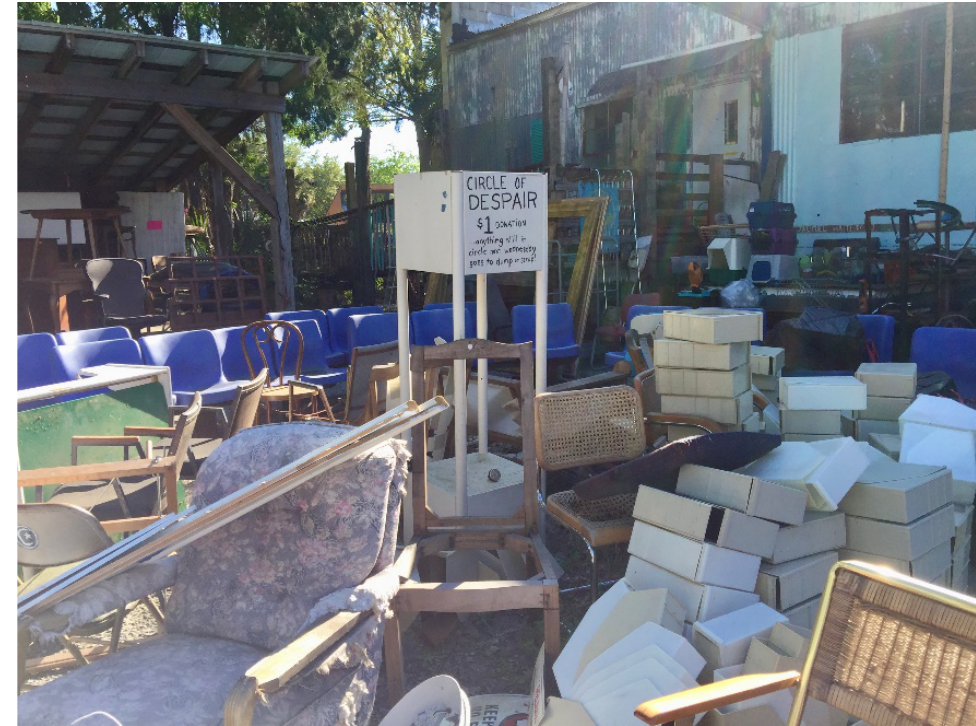
Figure 5. The Circle of Despair at The Repurpose Project, 2018.